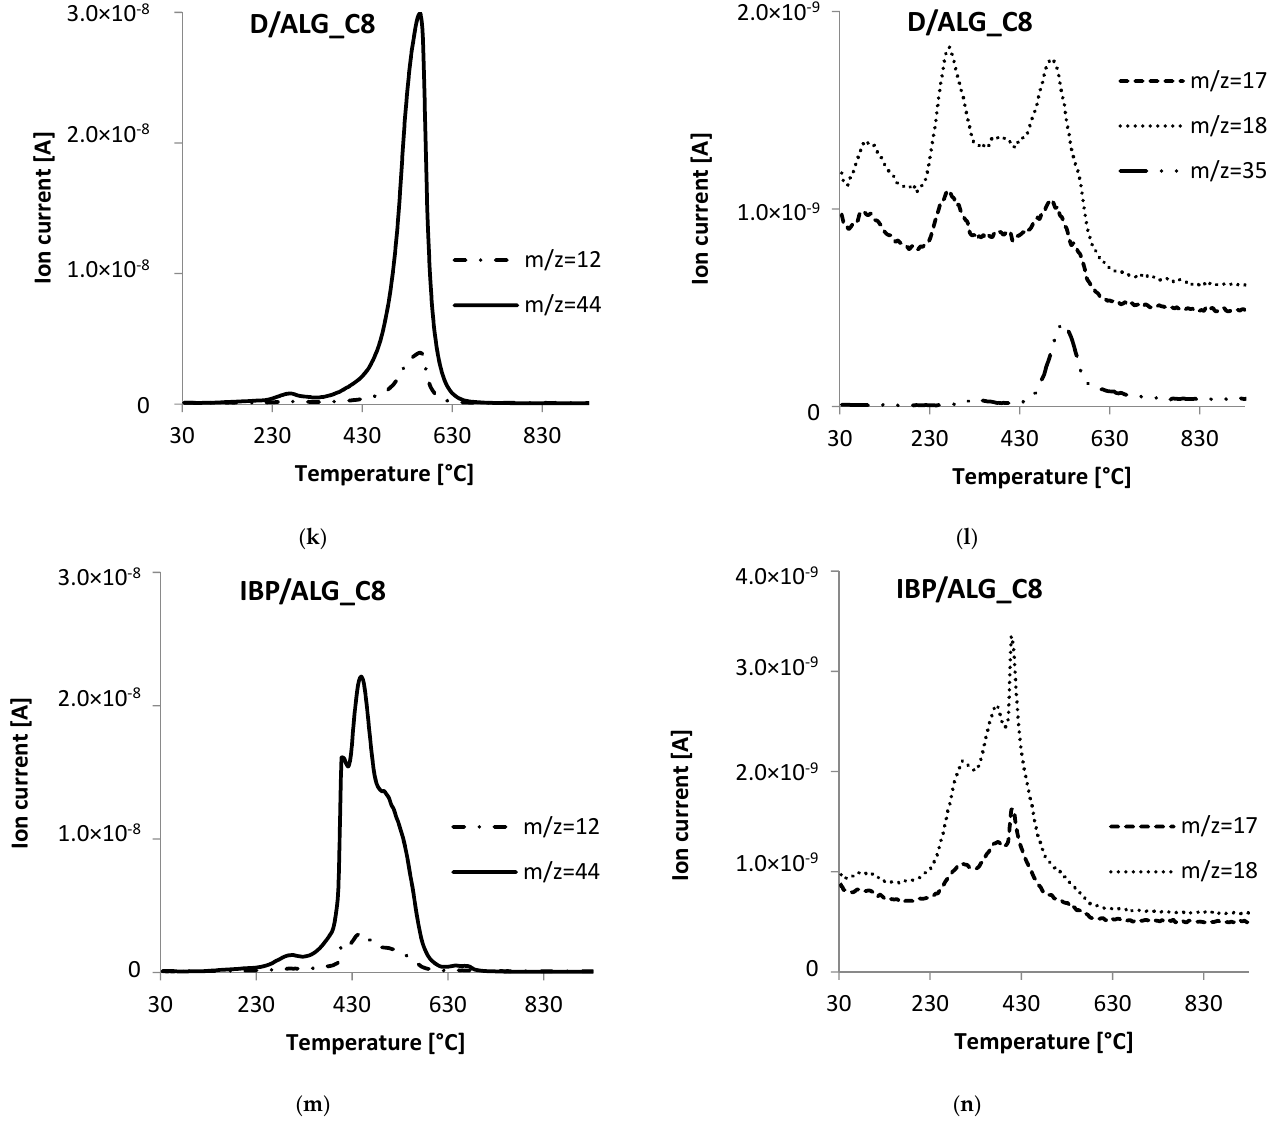
Figure 11. MS profiles of the primary gaseous ALG_Ca ( a , b ), C ( c , d ), ALG_C2 ( e , f ), ALG_C4 ( g , h ), and ALG_C8 ( i , j ) materials, in addition to ALG_C8 after diclofenac ( k , l ) and ibuprofen ( m , n ) adsorption, degradation products: OH ( m / z = 17), H 2 O ( m / z = 18), CO 2 ( m / z = 44), C ( m / z = 12) and Cl ( m / z = 35).